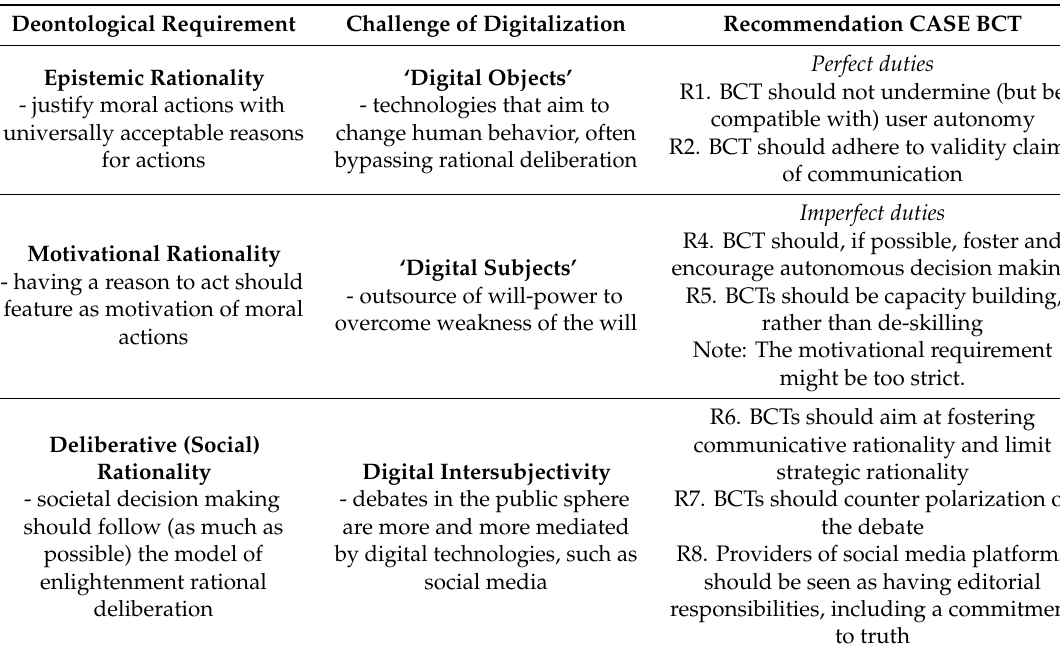
Table 1. Deontological Requirements and